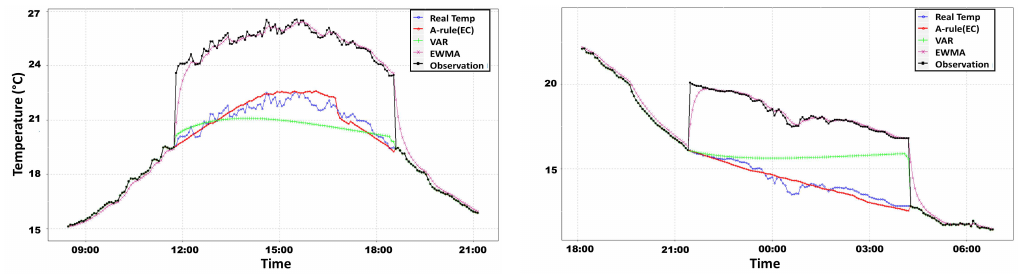
Figure 9. Detection and correction of synthetic faulty data from a temperature